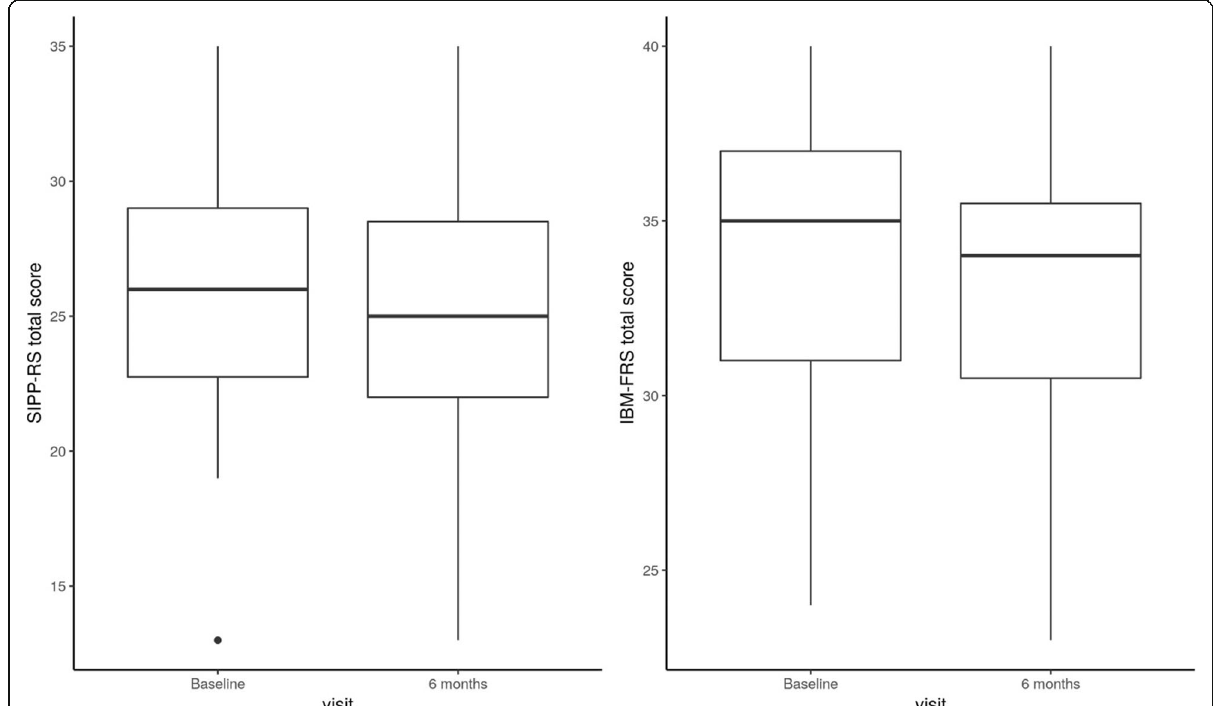
Fig. 2 Change over time for the SIPP-RS and the